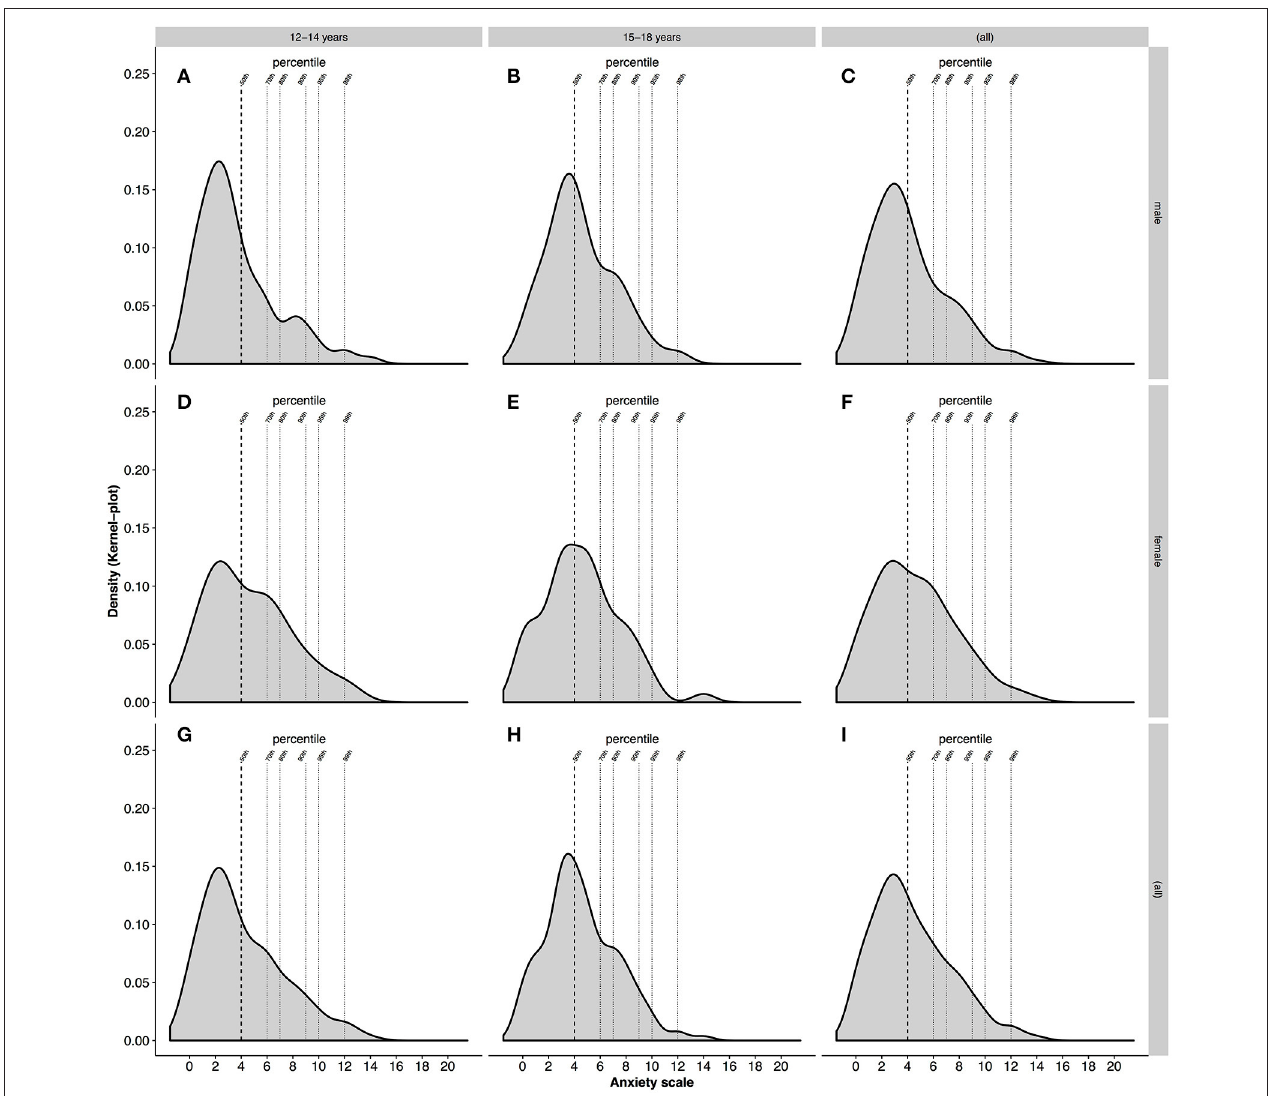
FIGURE 4 | Density of the distribution of anxiety. (A–C) Shows male athletes in late childhood, late adolescence and overall, respectively. (D–F) Shows female athletes in late childhood, late adolescents and overall, respectively. (G,H) Shows late childhood and late adolescents regardless of gender. (I) Shows the density of anxiety for all